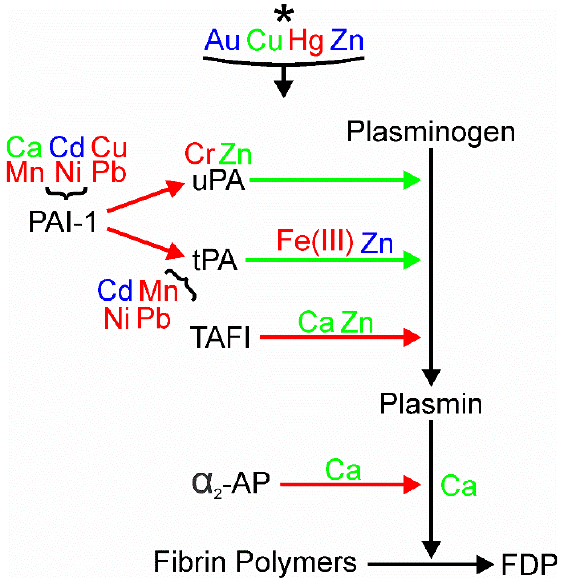
details about the specific coagulation enzymes and pathways depicted.